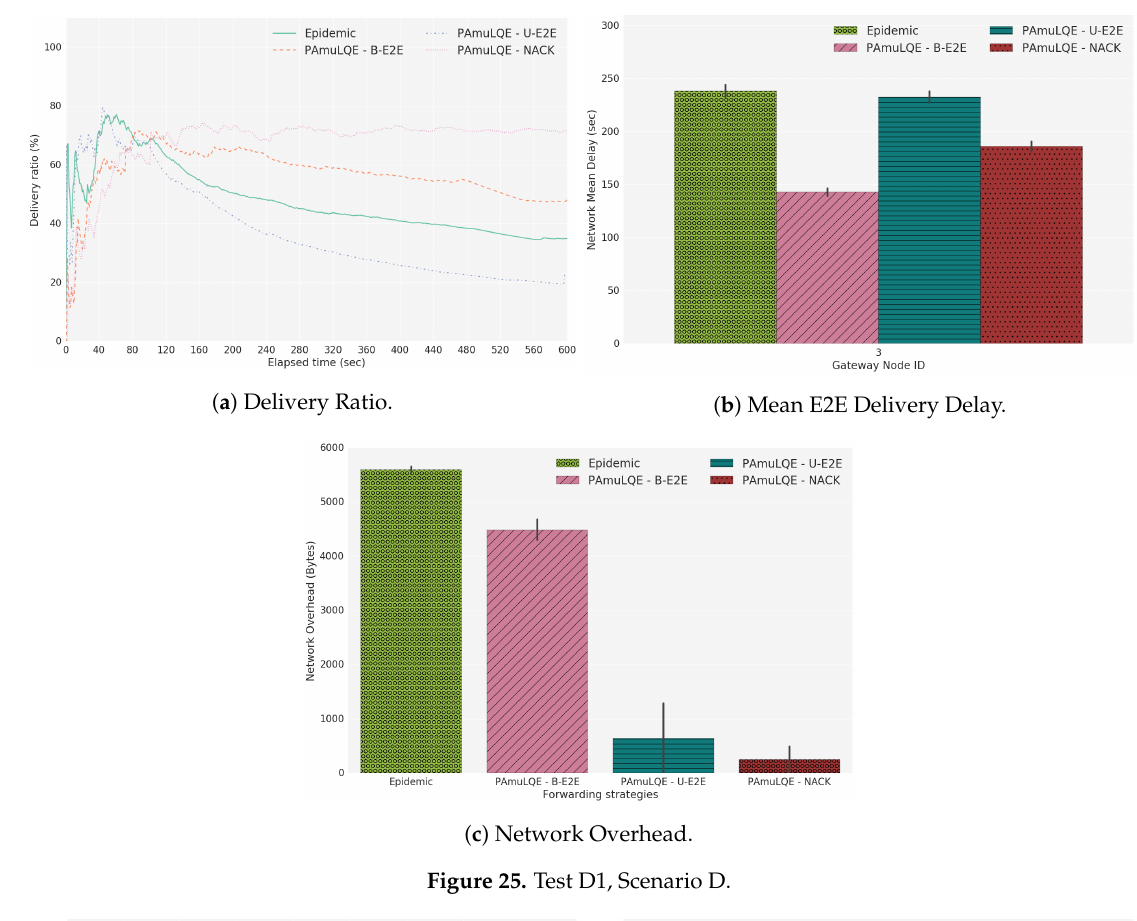
Figure 25. Test D1, Scenario D.